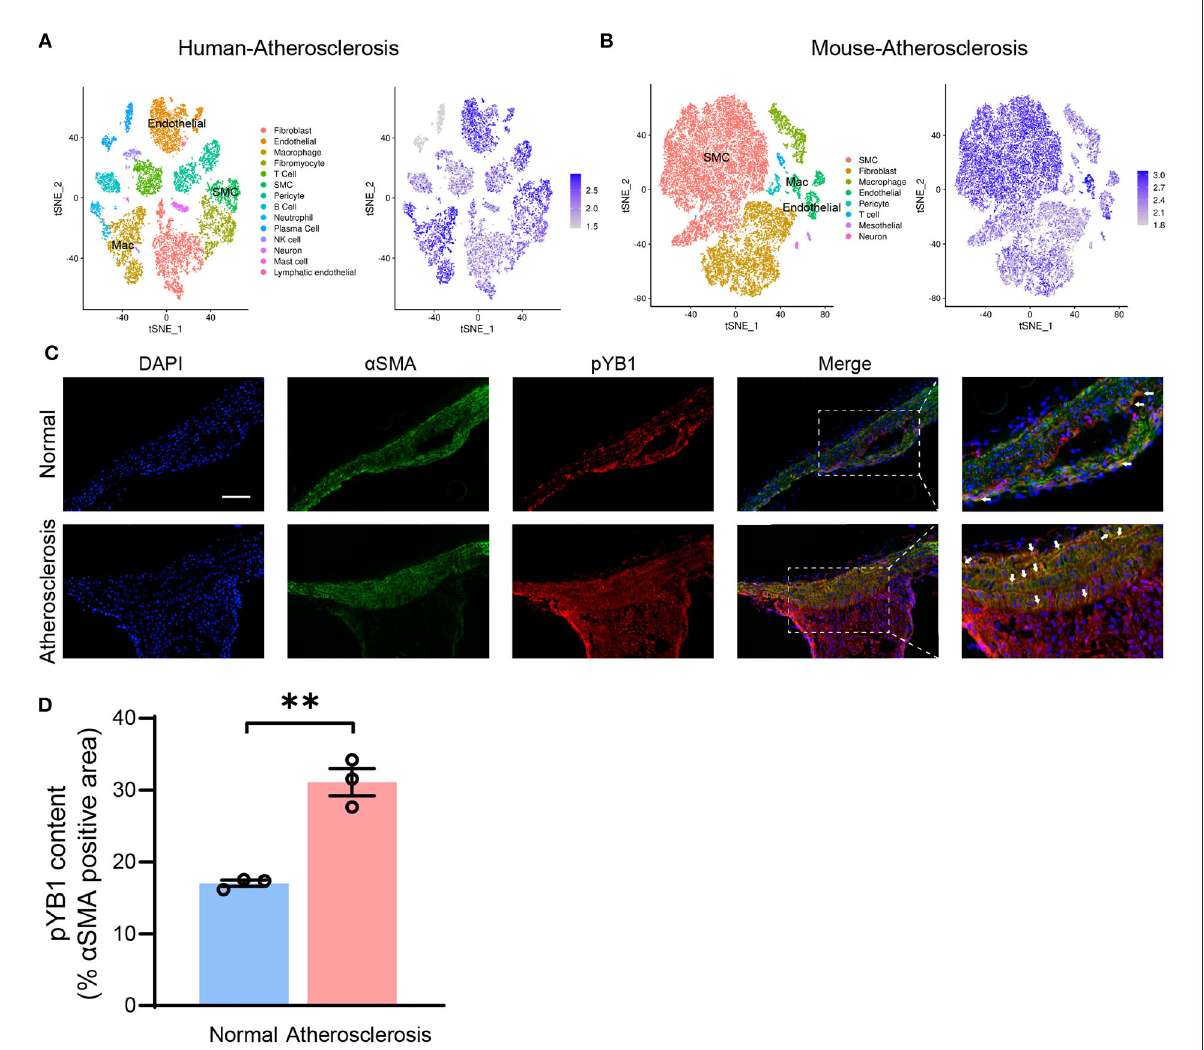
FIGURE4 Phosphorylated YB1 was elevated in smooth muscle cells in atherosclerotic mice. (A) t-stochastic neighbor embedding (t-SNE) visualization of cell types present in human atherosclerosis aortic tissue (left), and the expression of the gene YBX1 (encodes YB1, right). (B) t-SNE visualization of cell types present in mouse atherosclerosis aortic tissue (left), and the expression of YB1 (right). (C) Representative images of immunofluorescent co-staining of α SMA and pYB1 in aortic arches, and the related quantitative analysis (D) . Abbreviations in (A) SMC, smooth muscle cell; Mac, macrophage. Data are presented as the mean ± SEM. Student’s two-tailed t -test. ** P < 0.01 vs. Normal, Scale bar = 100 µ m ( n = 3–5 for each